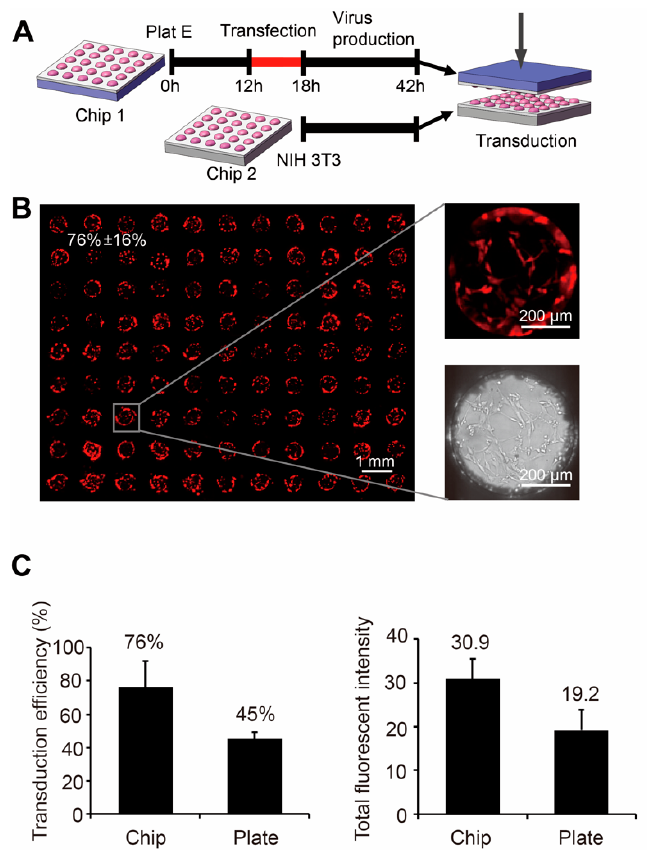
Figure 4. Gene delivery through virus transduction on the SMAR-chip. ( A ) The schematic of virus packaging and target cell transduction. The packaging cells (Plat E) were seeded on the SMARchip and transfected with the virus plasmids encoding RFP. Then, 48 h after the transfection, the virus containing chip was turned upside down and aligned with the chip seeded with the target cells (NIH-3T3). ( B ) The fluorescent images of the NIH-3T3 cells two days after virus transduction. ( C ) Quantification of the transduction efficiency (left panel) and the total fluorescent intensity (right panel) of the on chip transduction (Chip) and conventional transduction in six-well plates (Plate).